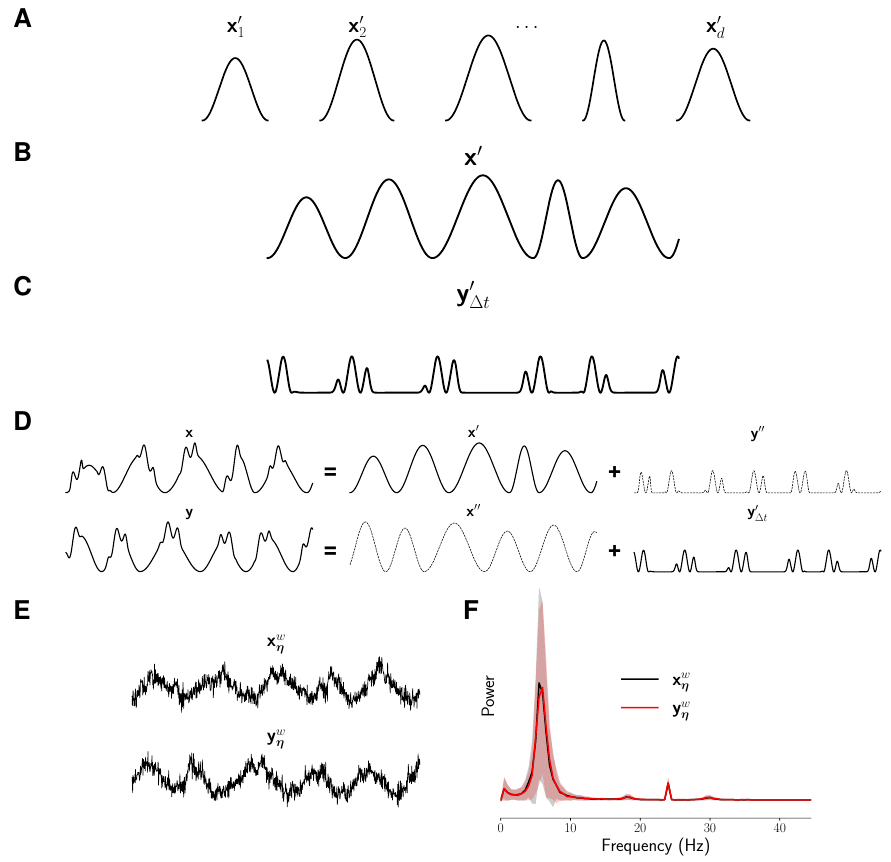
Figure 2. Schematic representation of the simulation model used to obtain data with directed phase-amplitude interactions. ( A ) Sinusoidal signal segments of varying amplitude and period ( x (cid:48) obtained after concatenating the sinusoidal signal segments. ( C ) A high frequency signal ( y (cid:48) ) modulated by x (cid:48) is computed through Equation (11). Then y (cid:48) is time-shifted by ∆ t seconds ( y (cid:48) ∆ non-interacting signals x (cid:48)(cid:48) and y (cid:48)(cid:48) to generate signals x and y . ( E ) Signals x and y are contaminated with noise and linearly mixed. ( F ) The resulting signals, x w η and y w η , have very similar power